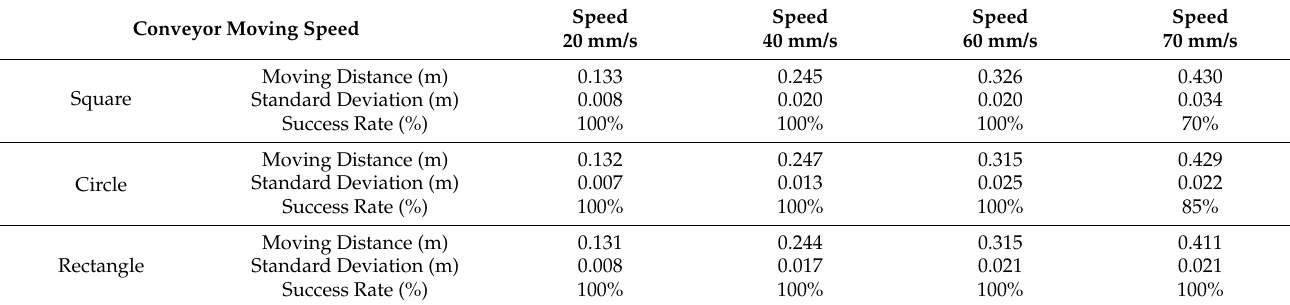
Table 4. Visual servoing results at different conveyor speeds.